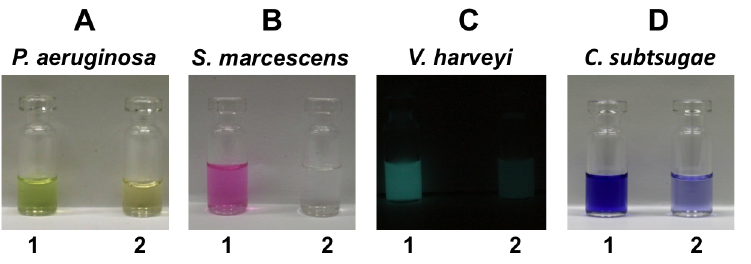
Figure 1. Quenching of QS-regulated pigments and bioluminescence by S.delphini . P. aeruginosa ( A ), S. marcescens ( B ), V. harveyi ( C ) and C. subtsugae ( D ) were each co-cultivated with S. aureus (1) or S. delphini (2) for 24 h. Pyocyanin, which is excreted by P. aeruginosa , was determined in the supernatant at its absorption maximum A 520 nm . Prodigiosin, which is cell wall bound in S. marcescens , was ethanol-extracted from the cell pellet and determined at its absorption maximum A 534 nm . Bioluminescence of V. harveyi was intensified by aeration before measuring in a bioluminescence reader. Violacein from C. subtsugae was quantitatively extracted with butanol and determined at its absorption maximum A 585 nm .